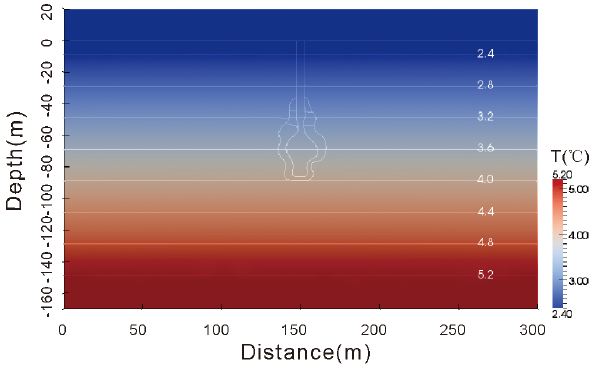
Figure 3. Initial reference temperature distribution around Ningwu ice